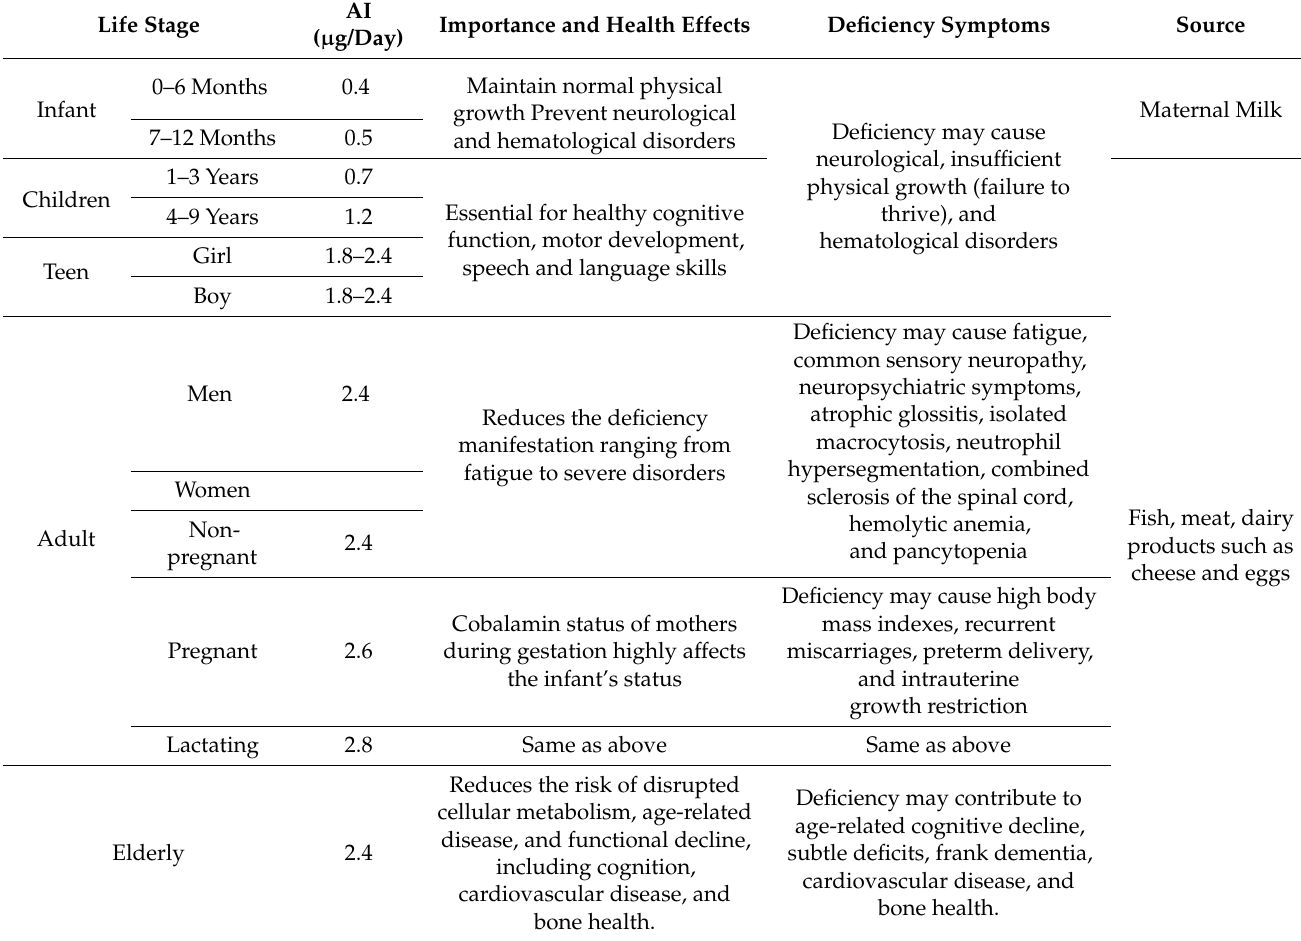
Table 8 comprises the dietary sources, RDA, and main actions of vitamin B12. Table 8. Adequate daily intake (AI), main actions, and natural sources of vitamin B12 (cobalamin) in different life